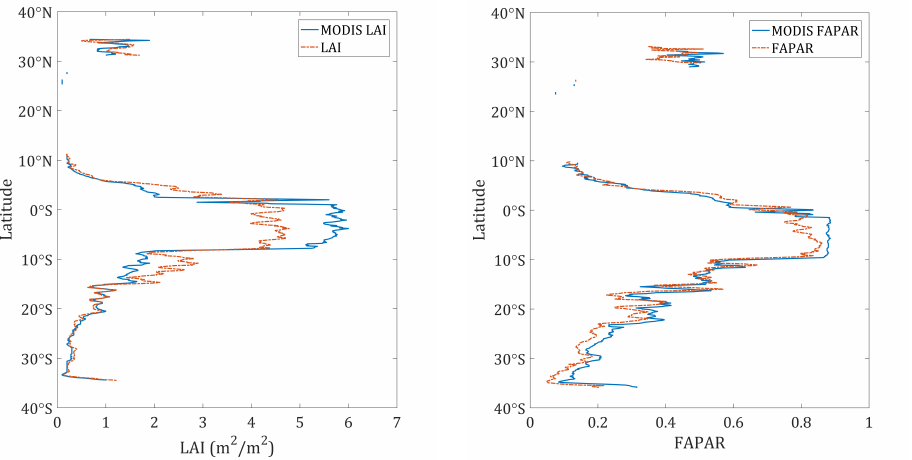
Figure 10. LAI ( left ) and FAPAR ( right ) latitudinal profiles over Africa (longitude 22 ◦ E) corresponding to the mean values of the GEE MODIS reference product and estimated by the proposed retrieval chain for the period